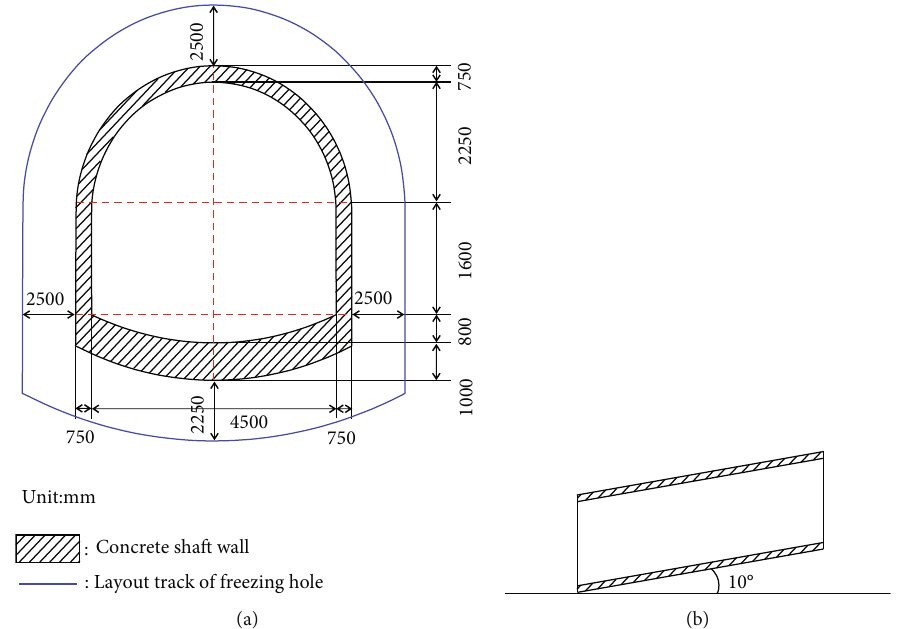
Figure 2: Schematic diagram of the inclined shaft section and layout parameters of the inclined freezing holes: (a) from the transverse section view, (b) from the longitudinal section view.